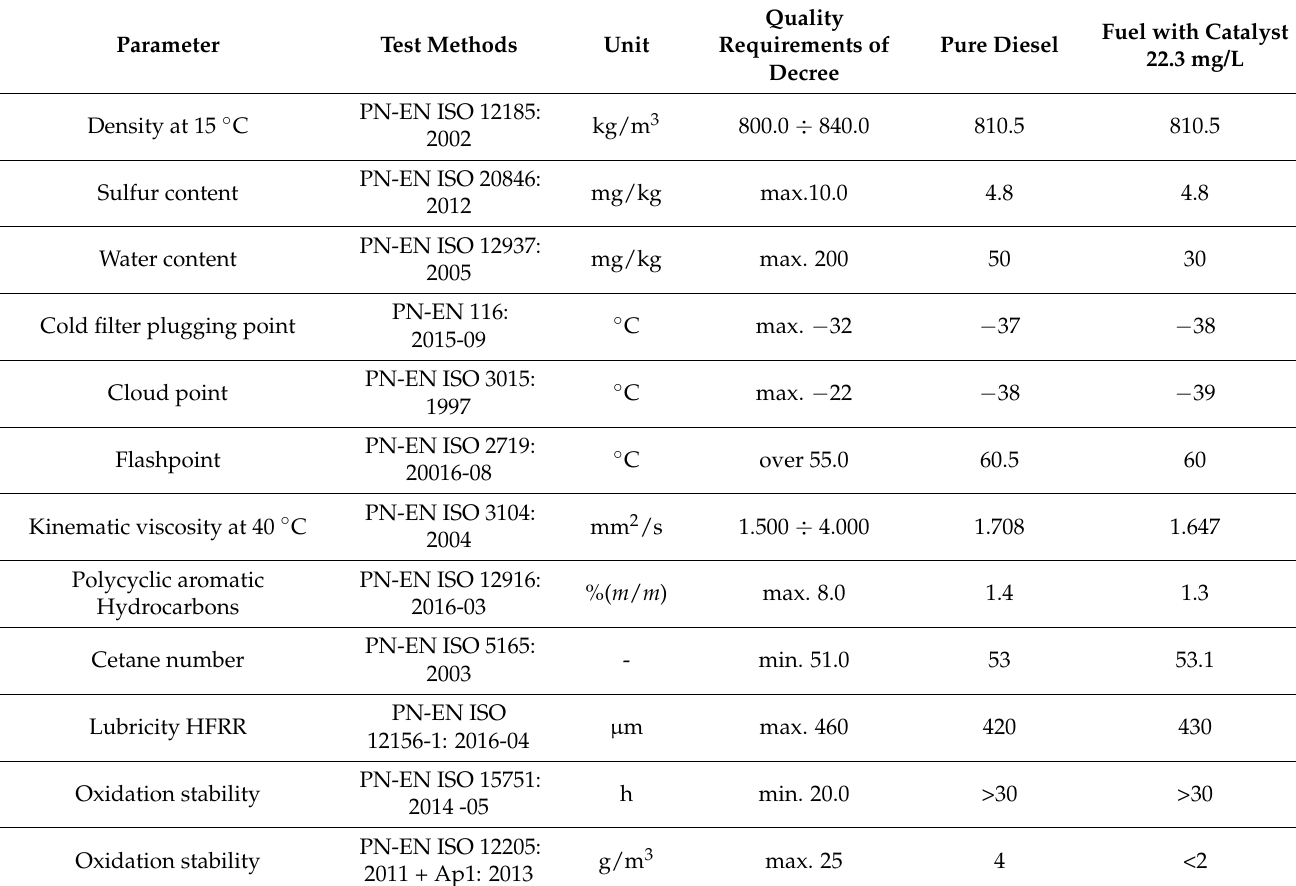
Table 3. The physical and chemical parameters of tested fuel